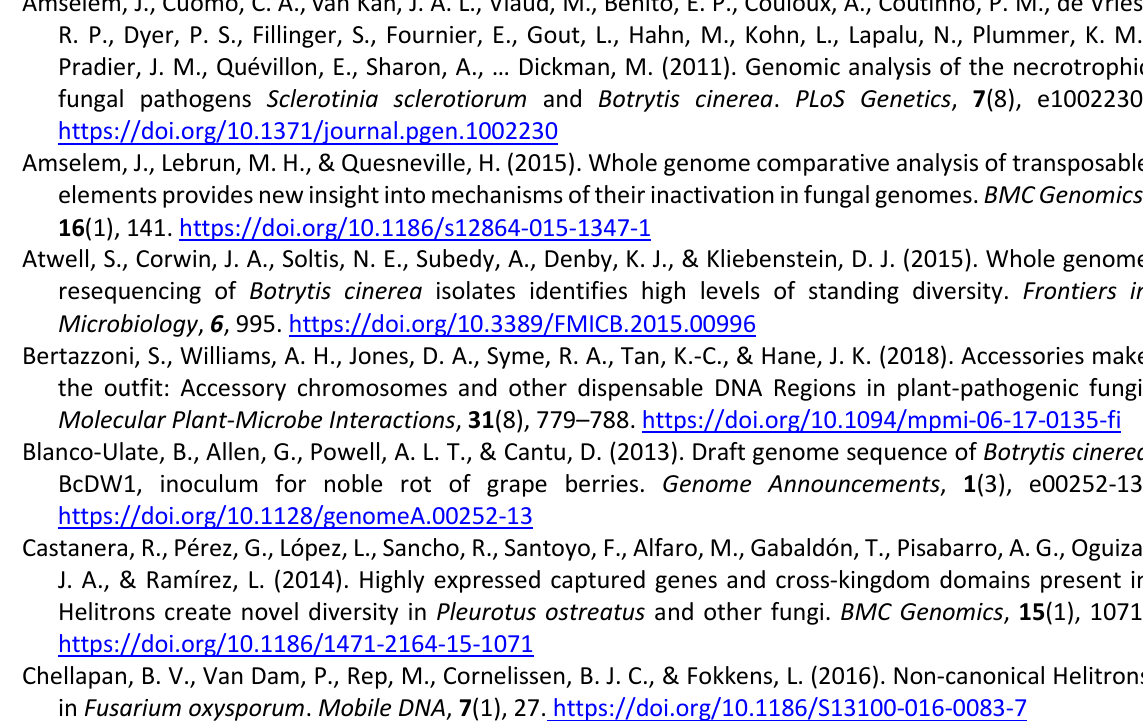
Figure S2: CHEF gel electrophoresis resolving accessory chromosomes of B. cinerea strains B05.10, Sl3 and Vv3. Figure S3: Synteny between the Core Chromosomes (CCs) of the B. cinerea strains B05.10, Sl3 and Vv3. Figure S4 : Main inversions events observed between the genomes of the B. cinerea strains Sl3 and Vv3. Figure S5: Localization of the PKS7 secondary metabolism gene cluster in the genomes of the B. cinerea strains B05.10 and Vv3. Figure S6 : Duplication of four contiguous genes in the genome of the B. cinerea strain Sl3. Figure S7: Structure of the Telomere-Linked Helicase (TLH) identified in the B. cinerea strain Vv3. Figure S8: Positions of the genes encoding the Telomere-Linked Helicase (BcTLH) and of the Helitron- like Transposable Elements (TE) in the genome of the B. cinerea strain Vv3. Figure S9: Alignment of the ten consensus sequences corresponding to the Boty /Gypsy_1 Transposable Element (TE) identified in the genomes of the B. cinerea strains B05.10, Sl3 or Vv3. Figure S10: Helitron-like Transposable Element (TE) identified in the genome of the B. cinerea strain Vv3. Figure S11: Localization of the main superfamilies of Transposable Elements (TEs) in the genomes of the B. cinerea strains Sl3 and Vv3. Figure S12: GC content of complete copies of the main subfamilies of Transposable Elements (TEs) in the genomes of the B. cinerea strains B05.10, Sl3 and Vv3. Figure S13: Principal Component Analysis (PCA) of the repertoires of small RNAs in different strains of B. cinerea . Figure S14: Retrotransposons that generate small RNAs in the B. cinerea strains Sl3 and/or Vv3. Figure S15: Mapping of small RNA reads on complete copies of TEs in relation to their GC percent. Figure S16: Small RNAs produced by the B. cinerea strains Sl3 and Vv3: size distribution and 5’ nucleotide. Figure S17: Positions of complete copies of the TE Copia_4, Gypsy_6 and Gypsy_7 in the B. cinerea Vv3 genome. Figure S18: Alignment of Copia_4, Gypsy_6 and Gypsy_7 consensus sequences with their respective complete copies in Vv3